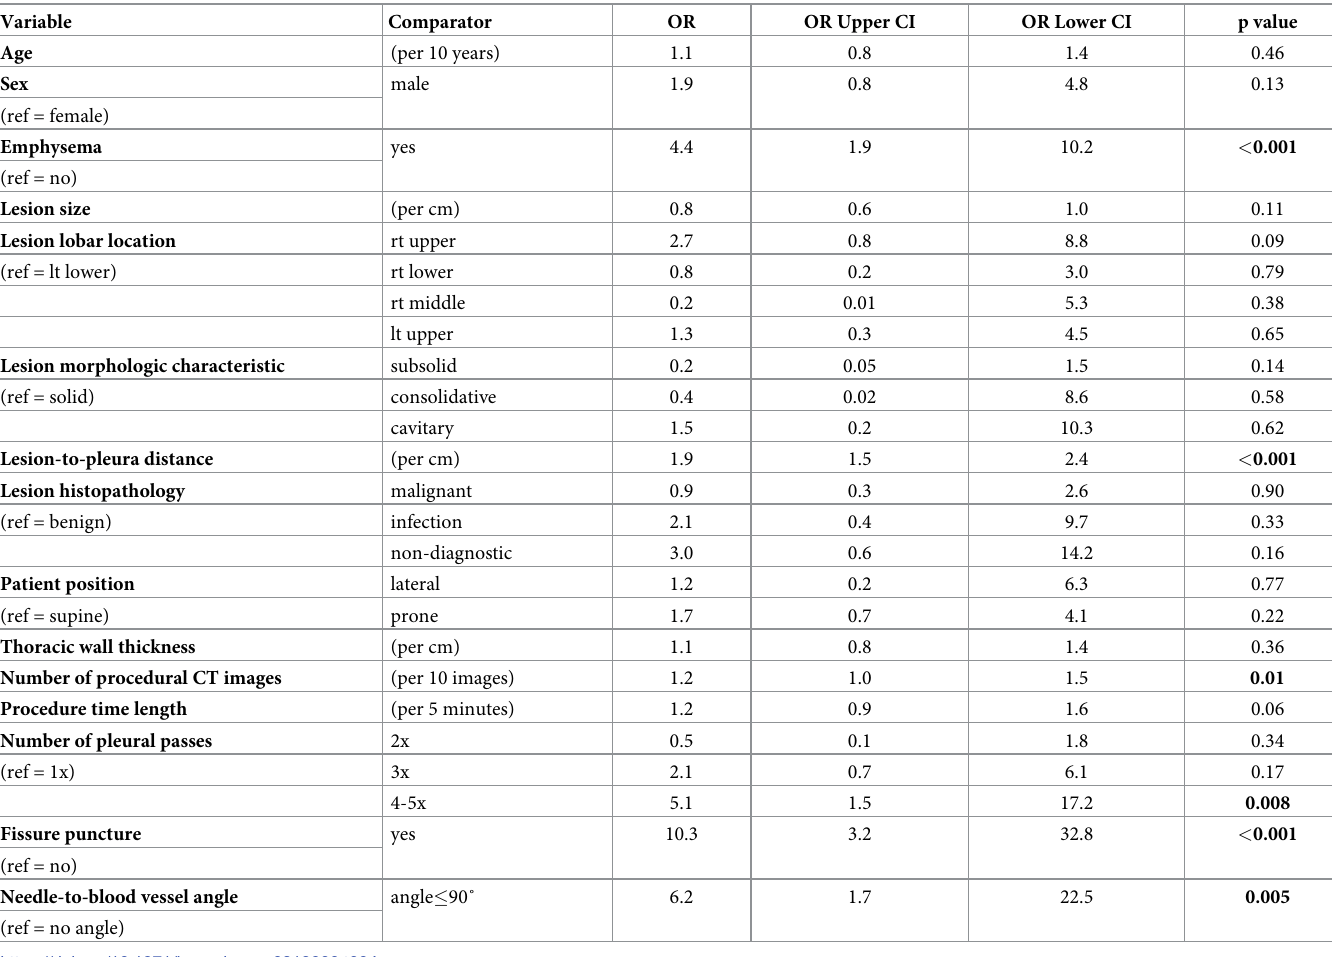
Table 4. Univariate logistic regression analysis (no and minor complications SIR0-2 vs. major complications SIR3-4) of all variables in the study group (n = 311).